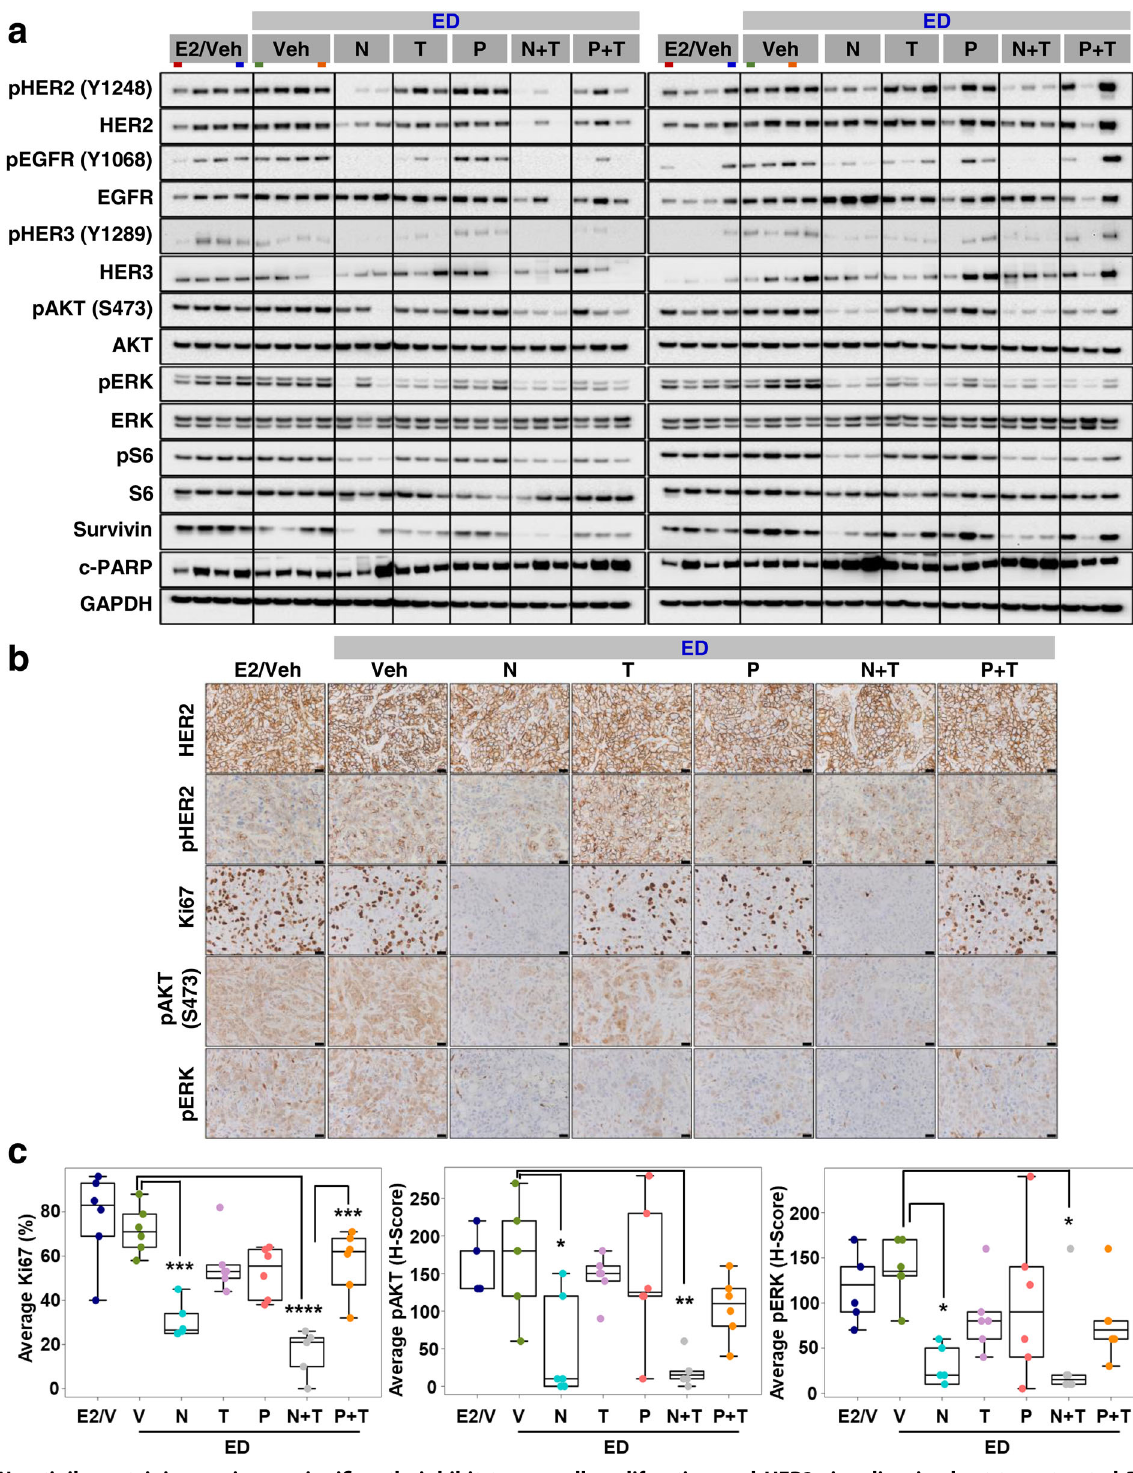
Fig. 3 Neratinib-containing regimens signi fi cantly inhibit tumor cell proliferation and HER2 signaling in short-term treated BT474-AZ xenograft tumors. a Western blot analyses of alterations in level and activation of proteins along the HER signaling axis. Each of the seven short-term treatment arms had six tumors, which were run in two separate gels with each gel containing three tumors per arm. Colored bars below the treatment arms in gray boxes denote duplicate samples loaded as comparison control between the left and right blots. b Representative HER2, pHER2, Ki67, pAKT, and pP44/42 ERK immunohistochemical staining. c Box plots showing average Ki67 (%), pAKT ( H -Score), and pERK ( H -Score) protein levels by immunohistochemistry. Box plots indicate median and interquartile range (IQR). The lower and upper hinges correspond to the fi rst (25th percentile) and third (75th percentile) quartiles, respectively. The whiskers extend to about 1.5 × IQR from the hinge, and data points beyond the whiskers are suspected outliers. E2 estrogen, ED estrogen deprivation, Veh/V vehicle, N neratinib, T trastuzumab, P pertuzumab, IHC images in b are of ×40 magni fi cation, Scale bar: 50 μ m. * P < 0.05, ** P < 0.01, *** P < 0.001, **** P < 0.0001.